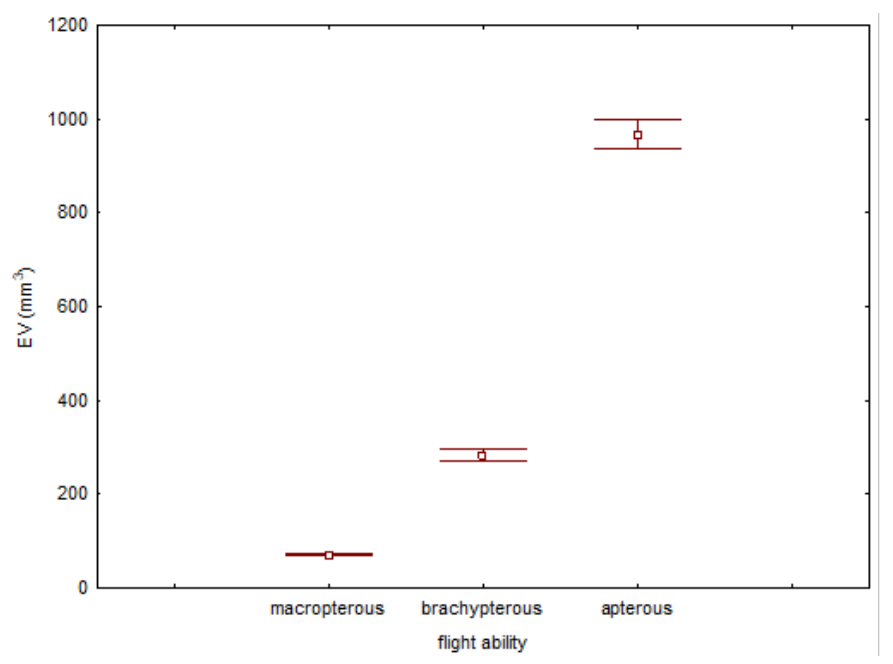
Figure 2. Mean EV values ( ± 95% CI) based on flight ability of carabids.